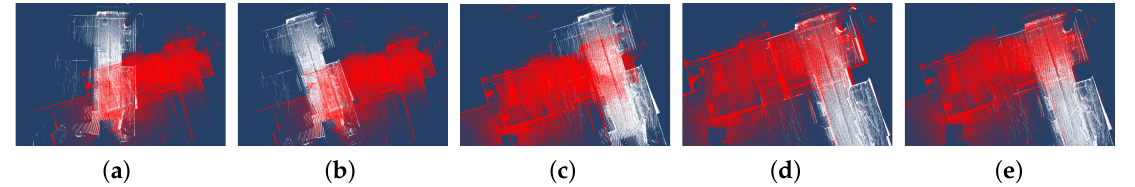
Figure 1. Step by step outline of the low overlapping point-cloud registration. ( a ) original alignment ( b ) result of rotation search ( c ) result of translation over y axis ( d ) result of translation over x axis ( e ) Iterative Closest Point (ICP)